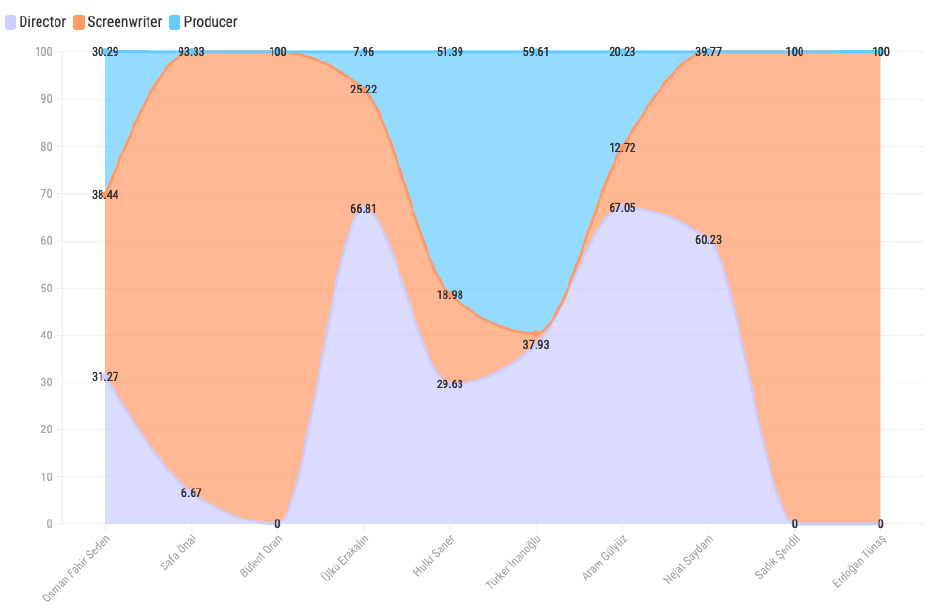
Figure 3. Percent stacked area charts showing the most prominent players and their professions based on weighted degree (1960-1979). A